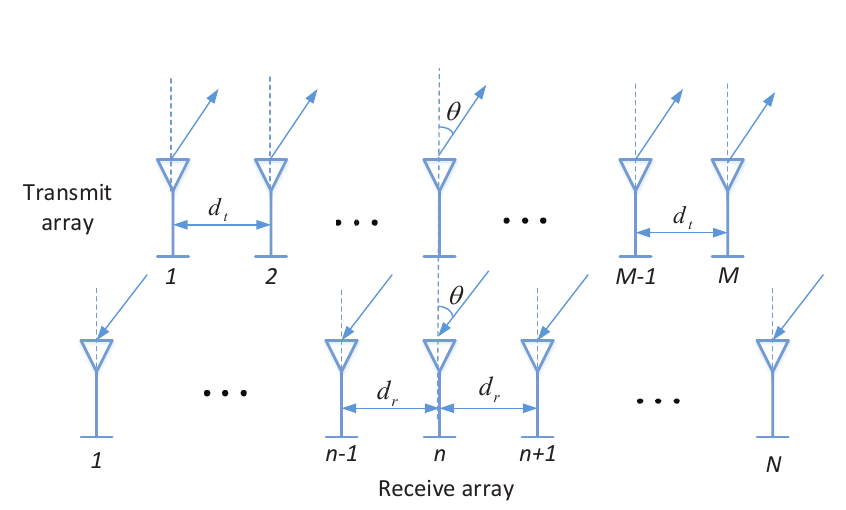
Figure 1. The configuration of the MIMO